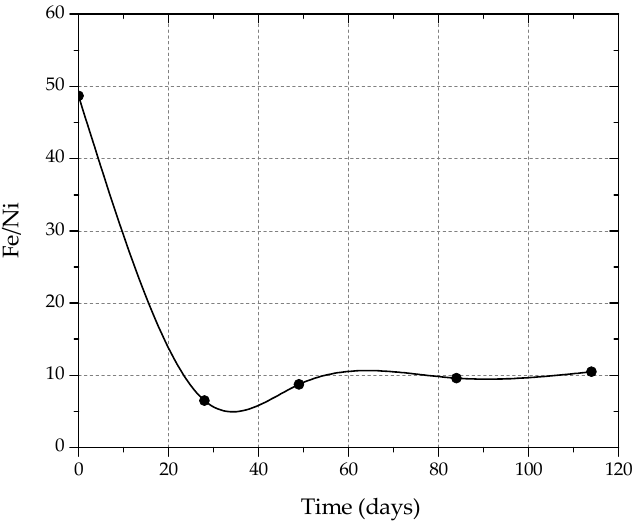
Figure 2. Fe/Ni ratio in the pregnant solution with time during leaching.